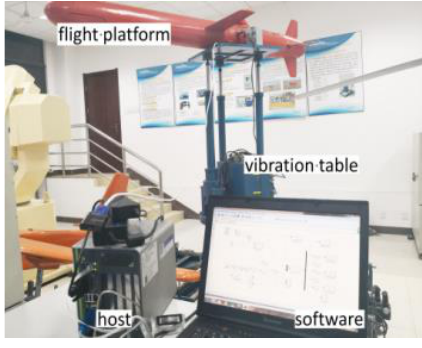
Figure 5. Semi-physical simulation platform.